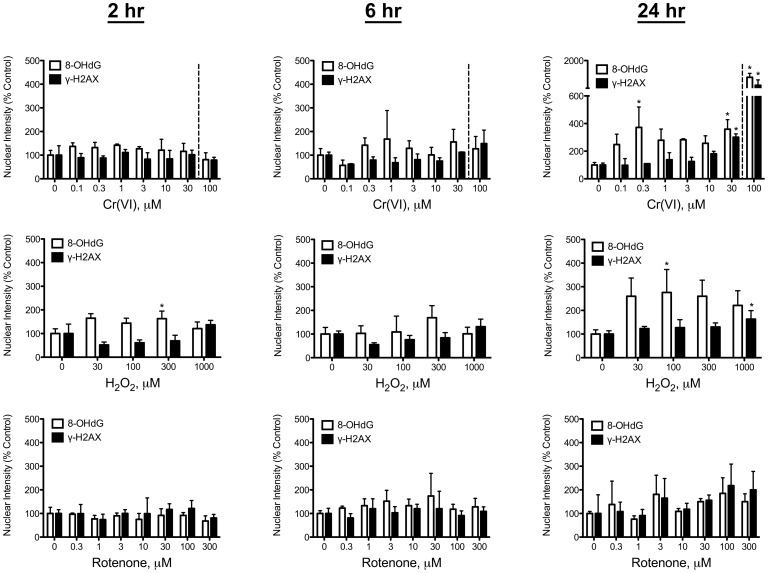
DNA damage in differentiated Caco-2.Nuclear staining intensity of 8-OHdG and γ-H2AX in differentiated Caco-2 cells. Cells were seeded at density 2×104 cells/100 µl/well in Collagen I coated plates, grown for 21 days, then treated with the indicated concentrations of Cr(VI) (top), hydrogen peroxide (middle) or rotenone (bottom). Nuclear staining intensity was measured after 2, 6, and 24 hours of incubation. Concentrations to the right of the dotted line of each plot were cytotoxic (reduced cell numbers) at 24 hr of exposure. Data are expressed as % Control, and represent mean ±s.d. (n = 3, where n is number of individual replicates). *p<0.05 by ANOVA followed by Dunnett’s test.